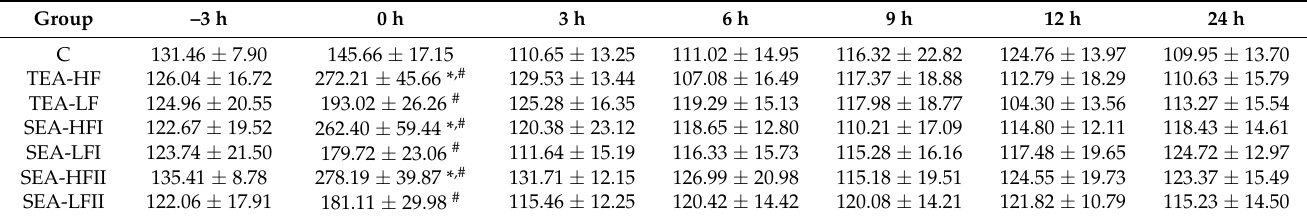
Table 4. Effects of different treatment methods on MTL activity at different time points ( ng/L, n = 6